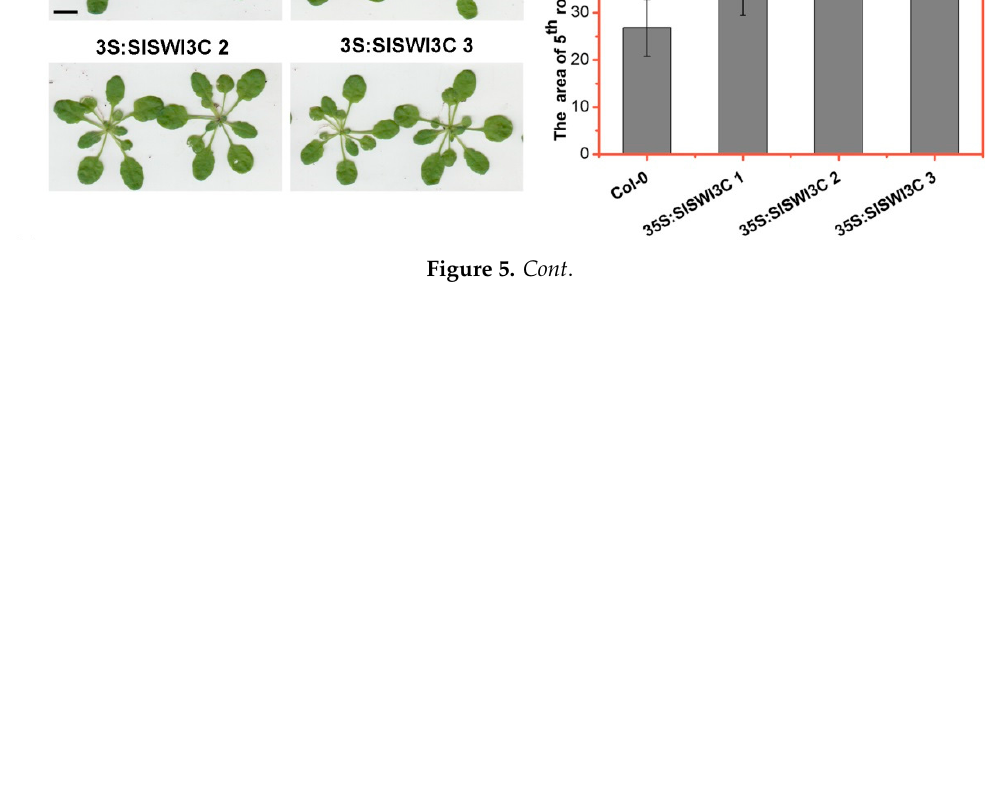
Figure 5. Overexpression of SlSWI3C enhances leaf growth. ( A ) Rosettes of 21-d-old Col-0 and 35S:SlSWI3C lines showing enhanced leaf growth. Three experiments were repeated with similar results, and one representative result was shown. Bar = 0.5 cm. ( B , C ) Total ( B ) and 5 th rosette ( C ) area calculated using ImageJ (http://rsb.info.nih.gov/ij/) software. The individual leaf from 21-d-old Col-0 and 35S:SlSWI3Cs plants was photographed and calculated using ImageJ. Error bars are SE ( n = 15). Asterisks indicate significant difference from the Col-0 ( p < 0.05, Student’s t test). The data are representative from three independent experiments. ( D ) SlSWI3C promotes the expression of GRFs in Arabidopsis . Expression levels determined by qRT-PCR in 21-d-old Col-0 and 35S:SlSWI3Cs rosettes grown in long-day (16 h light/8 h dark) conditions. qRT-PCR was amplified using gene-specific primers. The ACTIN2 ( AT3G18780 ) was used as an internal control. Error bars are SE. Asterisks indicate significant difference from wild-type plants ( p < 0.05, Student’s t test). The data are representative from three independent experiments. Next, we determined the role of SlSWI3C in the expression of the genes related to leaf development. As shown in Figure 5D, the expression levels of GROWTH REGULATING FACTOR 3 ( GRF3) , GRF5, and GRF6 were significantly increased in 21-day-old 35S:SlSWI3Cs shoots grown in long-day conditions compared with Col-0 (Figure 5D). GRFs are comprised of nine members (GRF1 to GRF9) [38] and stimulate leaf cell proliferation, since overexpression of GRF1 , GRF2 , and GRF5 enhances leaf growth and cell division [39,40]. Thus, the increased expression of GRFs in 35S:SlSWI3Cs may be responsible for the larger leaf size. Intriguingly, HB33 , a gene that is upregulated in brm mutants [26], was significantly downregulated in 35S:SlSWI3Cs plants (Figure 5D). 3. Discussion As one of the subunit of CRCs, SWI3 plays key roles in different cellular process in eukaryotic cells. In yeast, the SWI–SNF assembly and ATP-dependent H2A–H2B displacement are controlled by Swi3p [11,12]. Human BAF170 (SMARCC2) and BAF155 (SMARCC1), the homologs of Swi3p, are